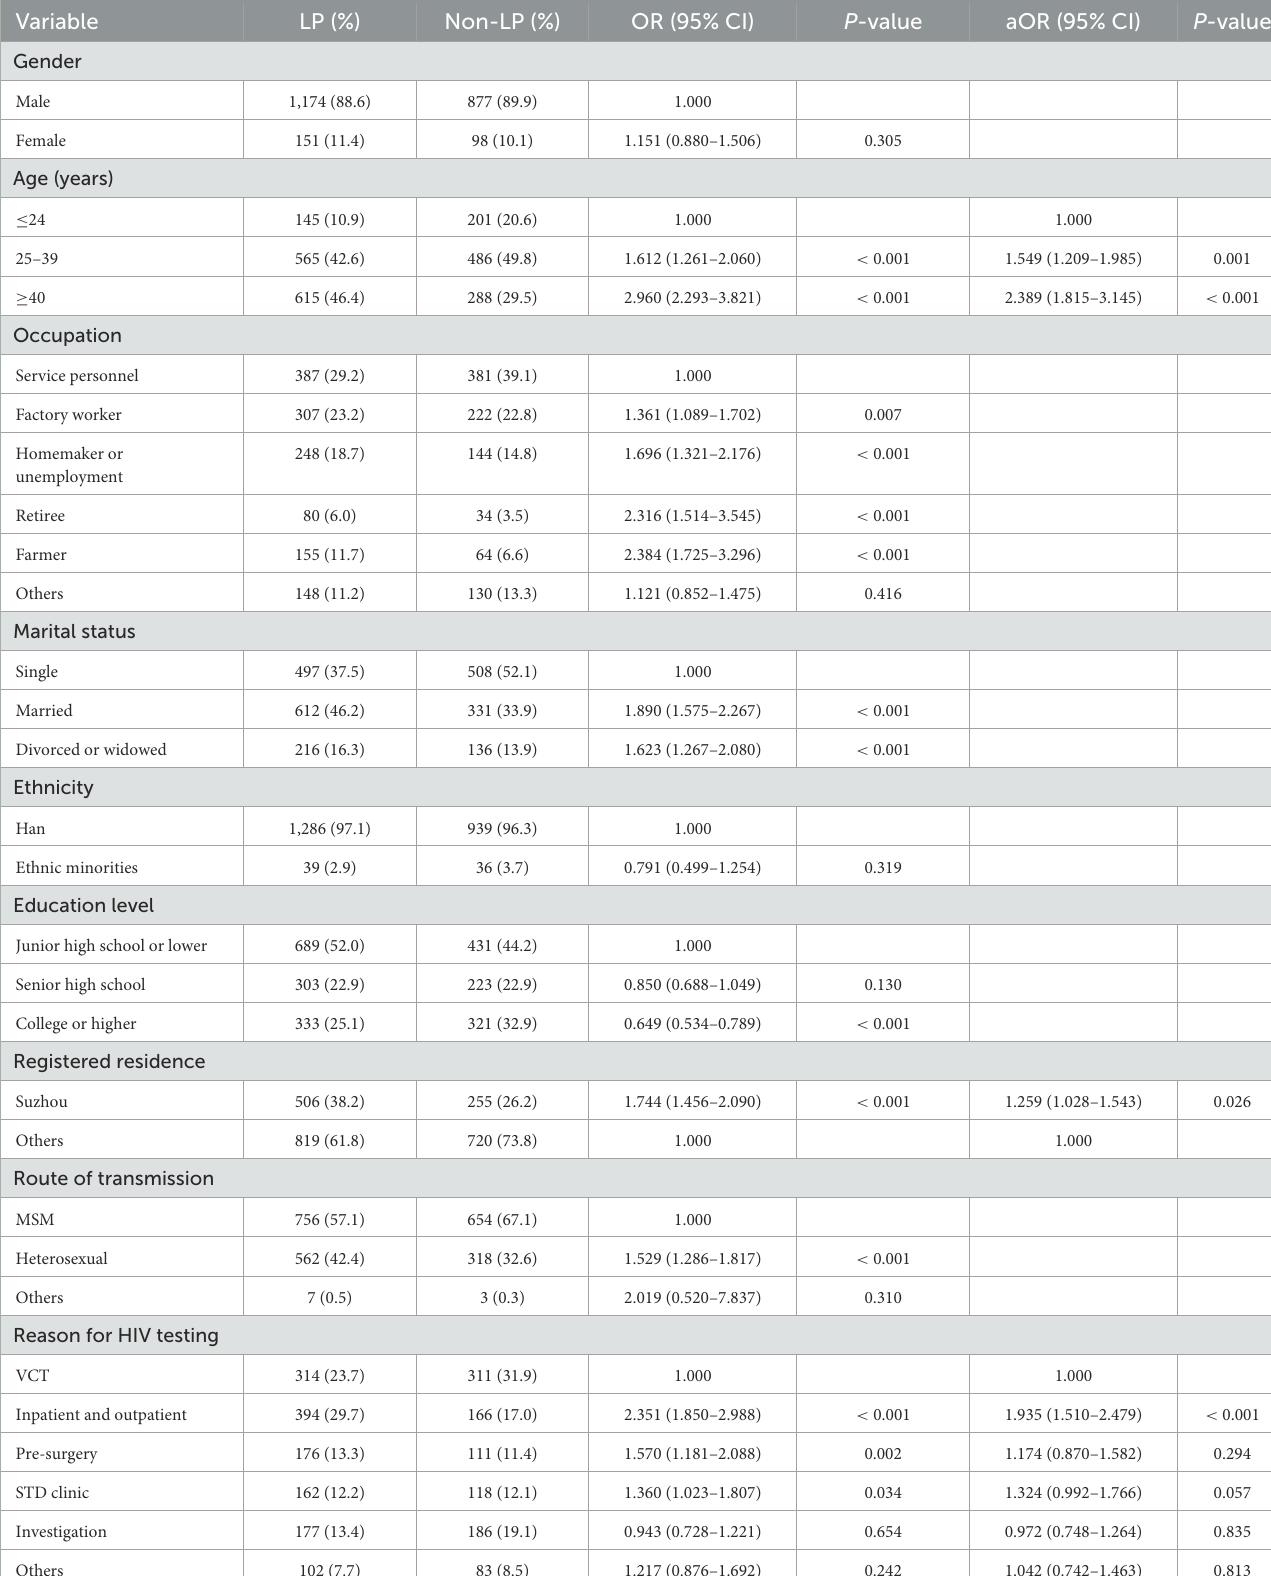
TABLE 3 Univariate and multivariate analysis of factors associated with late presentation of HIV infection.